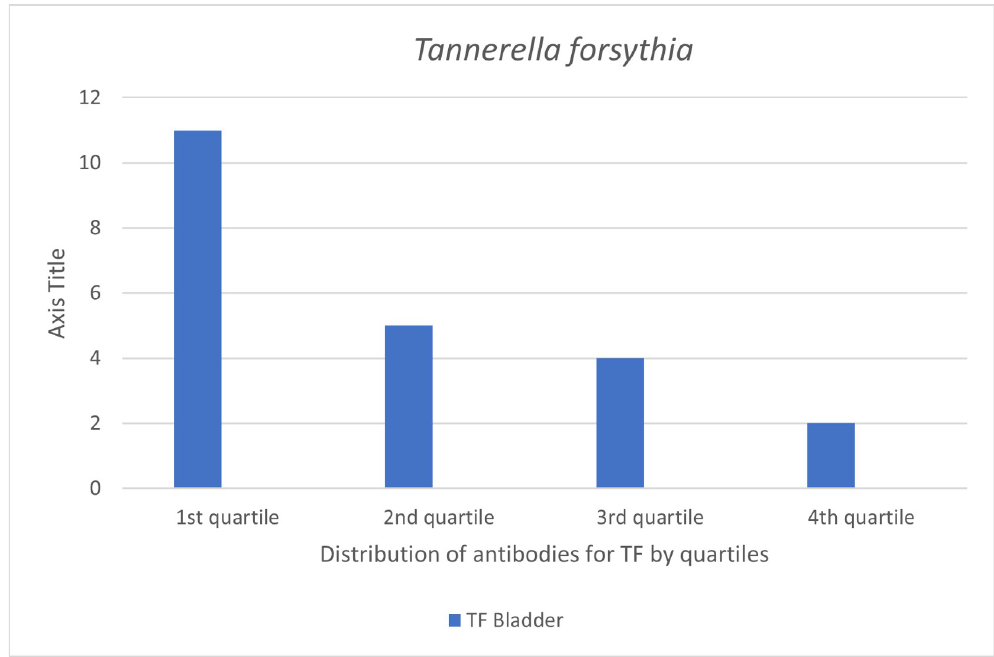
Fig 1. Number of incident cancer cases of bladder by quartile antibody levels of Tannerella forsythia (TF). Quartile (Q) values are Q1 9–35, Q2 36–58, Q3 59–104, Q4 105–1204.